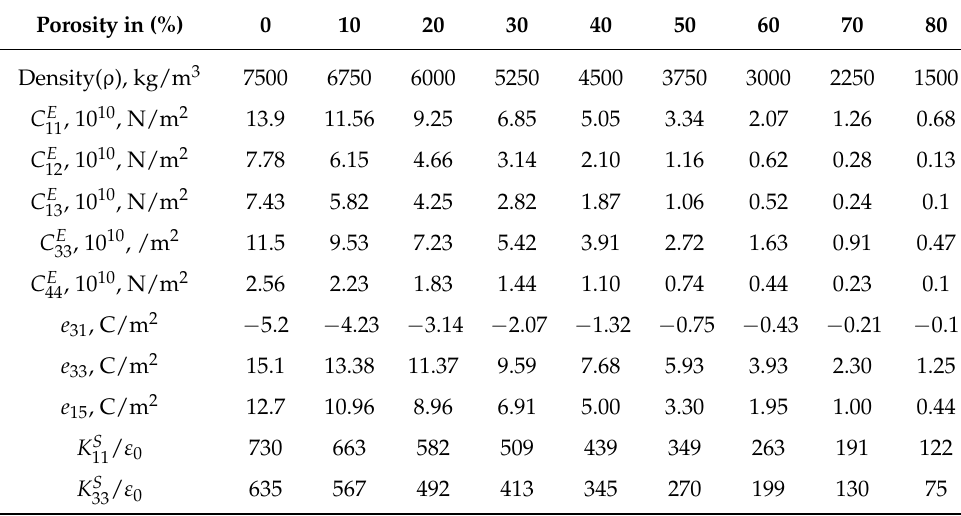
Table 3. Properties of the material of porous piezoelectric